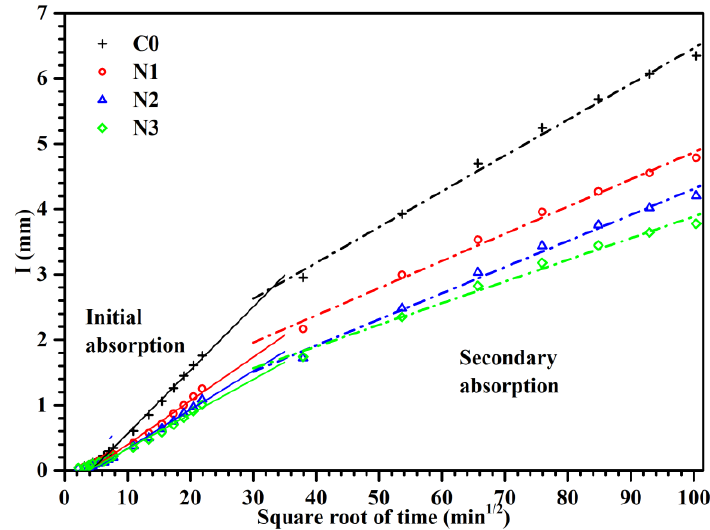
Figure 7. Capillary water absorption test results.